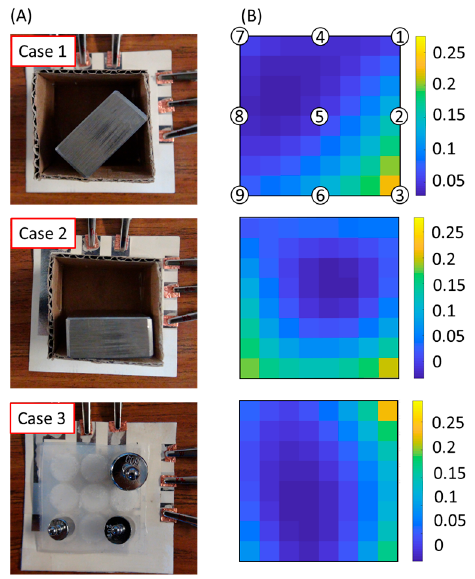
Figure 6. Demonstration of a force-sensing array. ( A ) For the first two cases, a metal bar was in two different positions in a cardboard box. The mass of the load was 284 g, and its dimensions were 19 mm × 37 mm × 52 mm. For the third case, the weights were 10 g, 20 g and 50 g. ( B ) The calculated distribution of forces retrieved from the capacitive measurements and regularization. The color maps from the top downwards show the distribution of normalized force on the sensor array corresponding to Case 1, Case 2, and Case 3, respectively. We used interpolation to fill the gaps between buttons. The buttons were in the center and along the edge of the color maps. The color bar is in terms of normalized force.